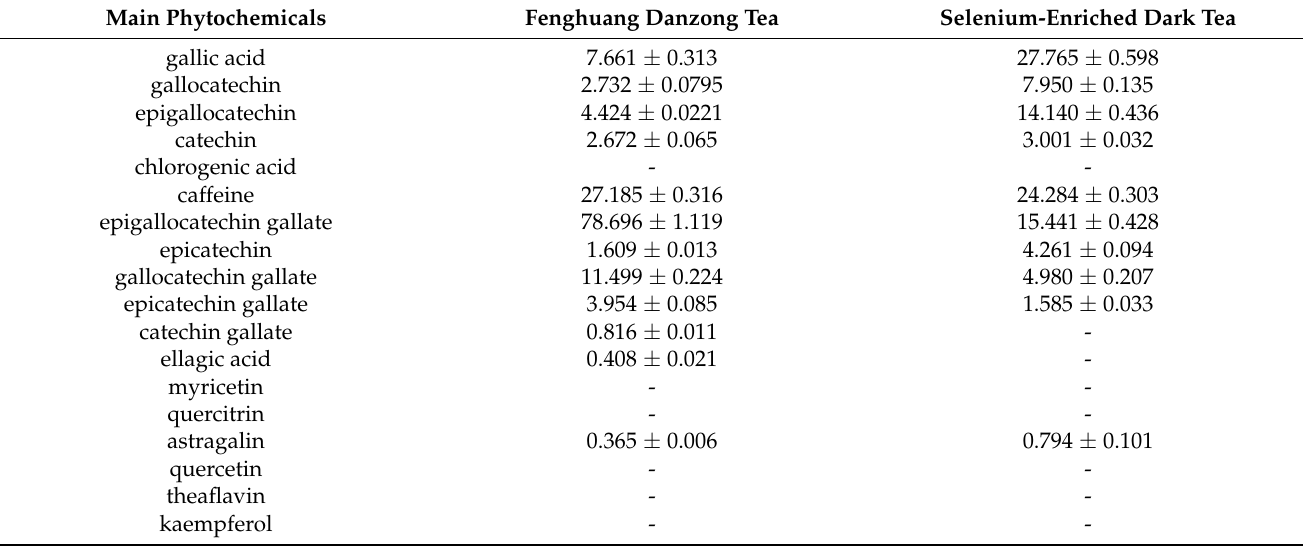
Table 3. The contents (mg/g DW) of main phytochemicals in Fenghuang Danzong and Selenium-Enriched Dark Tea. Main